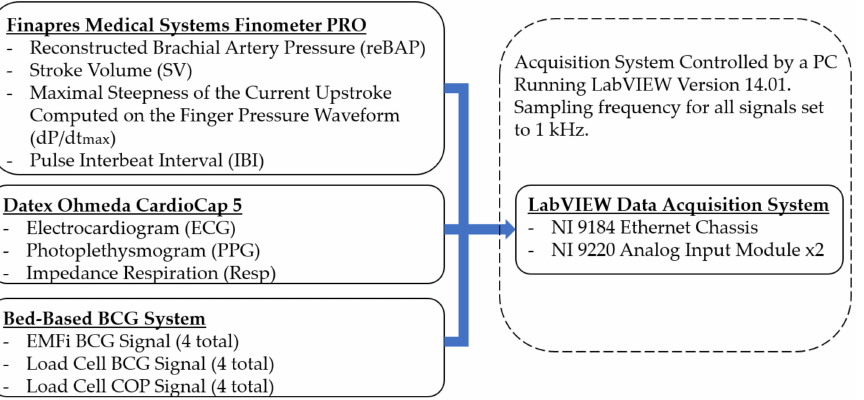
Figure 4. Signal management and acquisition. COP: center of position.